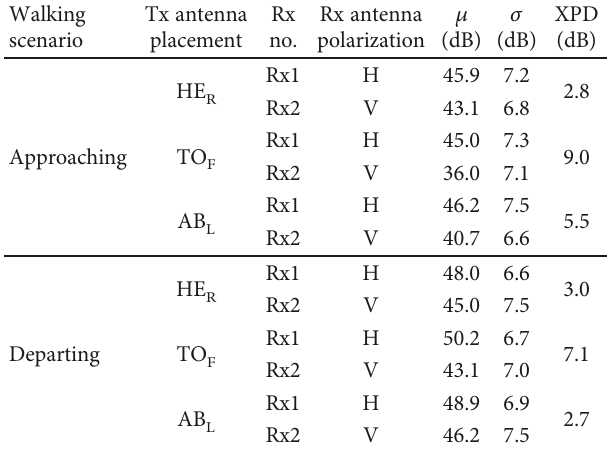
Table 4: The mean ( μ ) and standard deviation ( σ ) of system loss and the average XPD for di ff erent polarizations of the Rx antenna for walking scenarios in the ferry